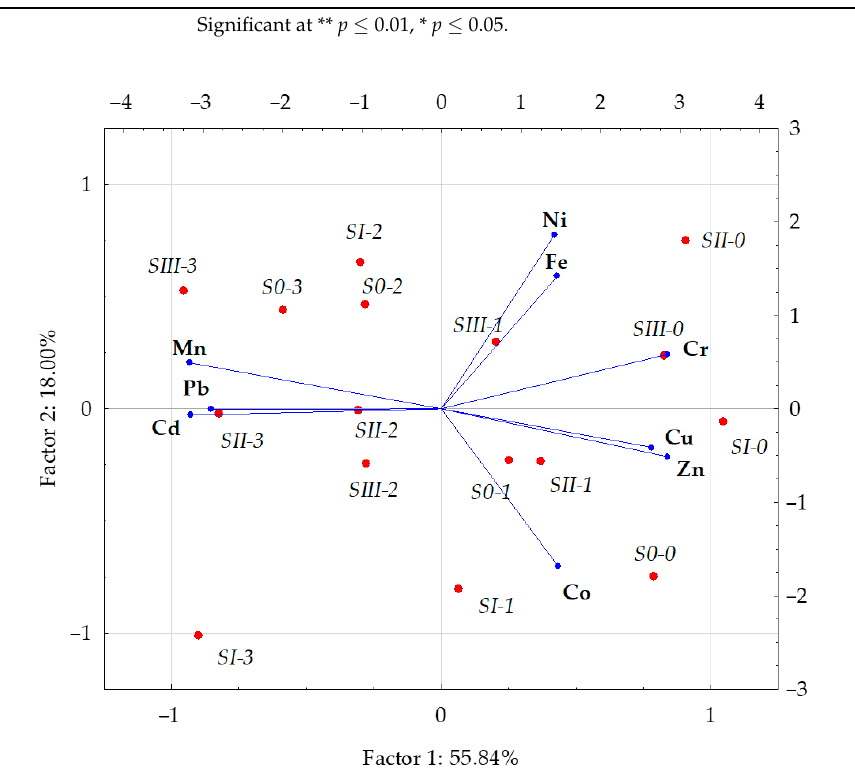
Figure 1. Content of trace elements in the aboveground parts of oat ( Avena sativa L.) illustrated with the PCA method. Key: vectors represent analysed variable (content of Cd, Pb, Cr, Ni, Zn, Cu, Mn, Fe and Co); points show the samples with elements ( S0 - without sewage sludge, SI - 4 g, SII - 8 g, SIII - 12 g sewage sludge per kg of soil; 0–0 cm 3 , 1–5 cm 3 , 2–10 cm 3 , 3–15 cm 3 diesel oil per kg of